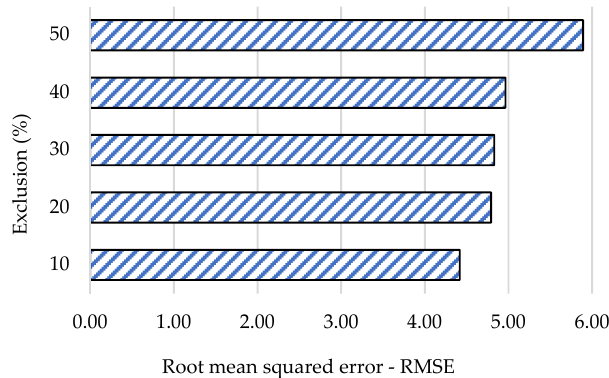
Figure 12. RMSE data from 10 to 50% of sample exclusion.